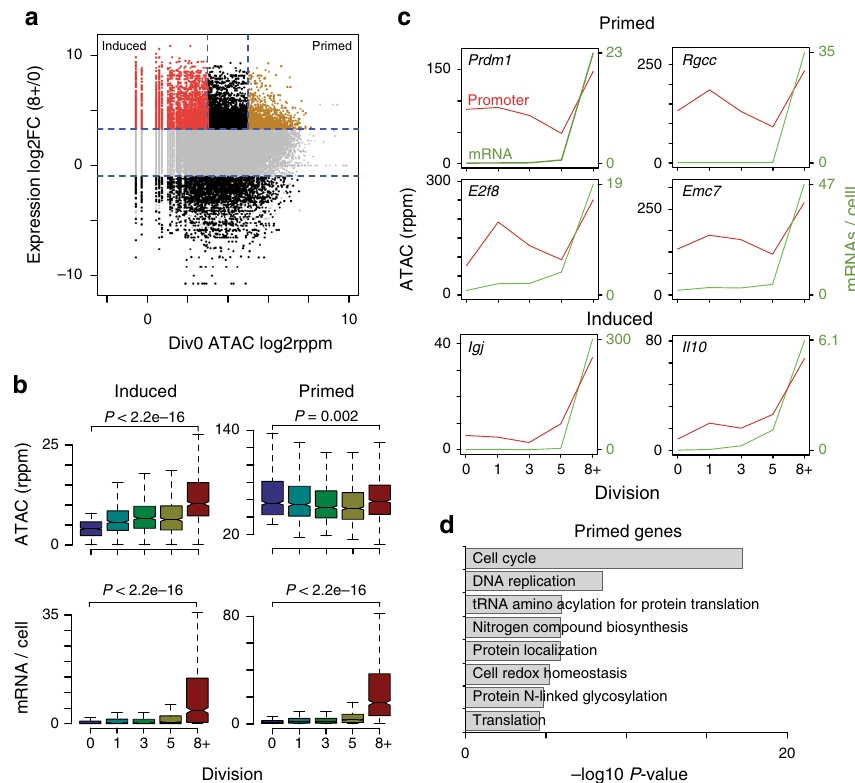
Fig. 5 A subset of promoters display a primed accessibility structure. a For all genes with signi fi cant gene expression changes between Div8 + and Div0, the change in gene expression is plotted vs. their promoter accessibility at Div0. Genes in which both expression and accessibility (log2 rppm < 3) was induced are labeled in red, and genes in which expression is increased at Div8 + but were highly accessibility at Div0 (log2 rppm > 5) were labeled as primed (gold). b For induced and primed gene sets, the promoter accessibility and gene expression kinetics are shown across all divisions. Boxplot center line indicates data median, lower and upper bounds of boxes the 1st and 3rd quartile ranges, and whiskers the upper and lower ranges of the data. Signi fi cance between Div0 and Div8 + was determined by two-tailed Student ’ s T -test. c The promoter accessibility and gene expression changes across all divisions for the indicated gene promoters with a primed (top) or induced (bottom) accessibility pattern. d Gene ontology results for primed accessible loci in gold from